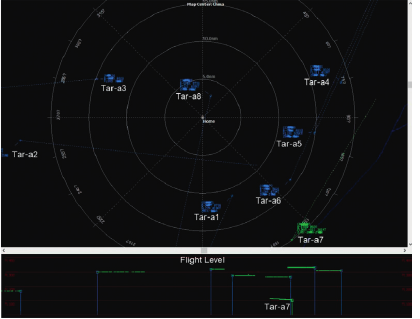
Figure 2: Flight trajectory tracking display in AirNav RadarBox at t � 60.